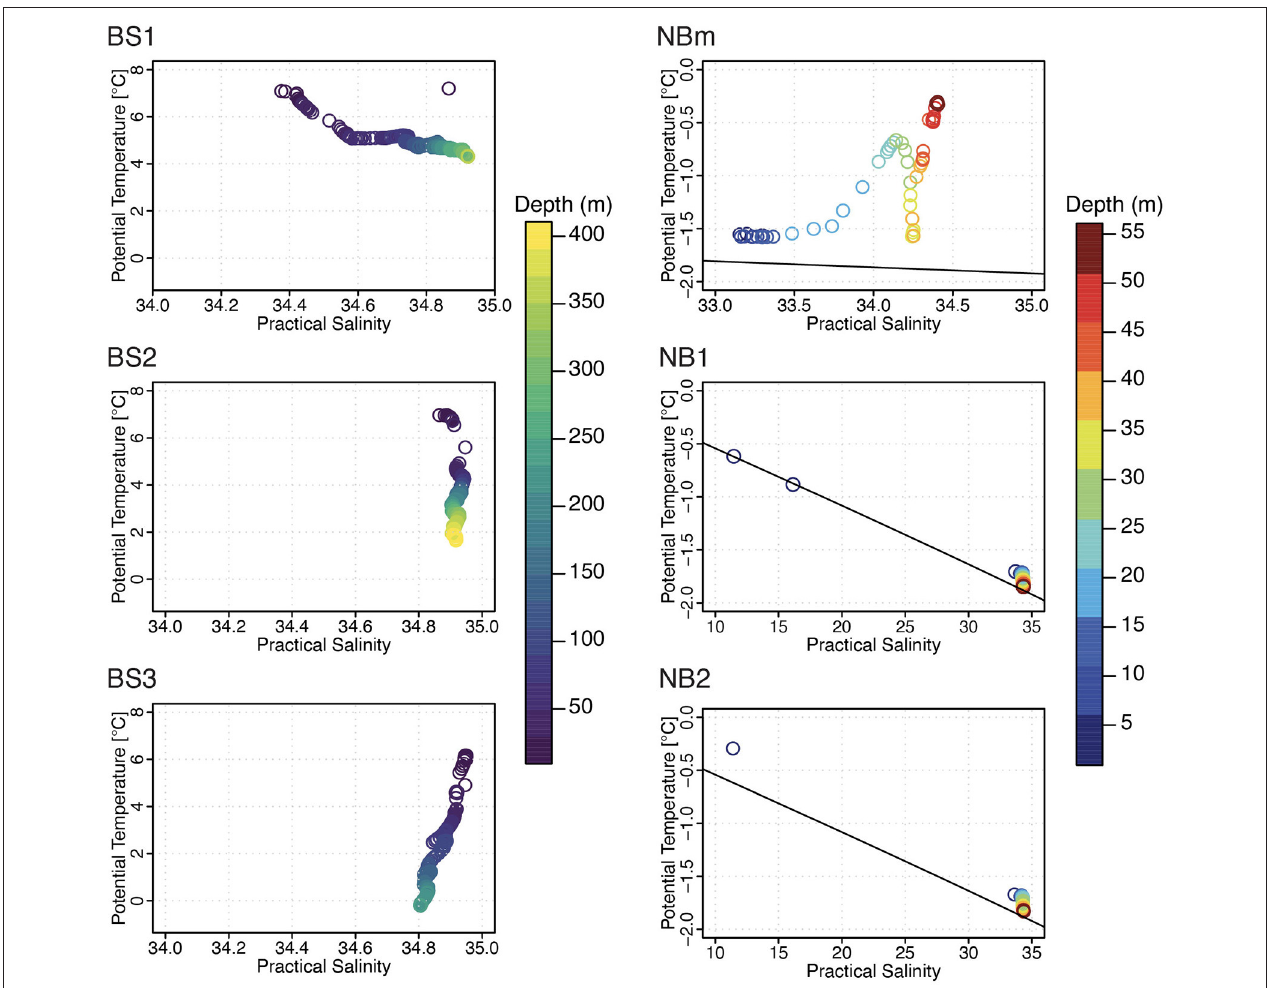
FIGURE 2 | A comparison of the marine physical environment using potential temperature-practical salinity diagram per sampling station. The water column depth (m) is denoted by color legend. Only surface water profile was recorded in NBm, NB1, and NB2 stations. Note the different range of scales at NBm (sea-ice margin) and NB1 and NB2 (sea-ice covered)